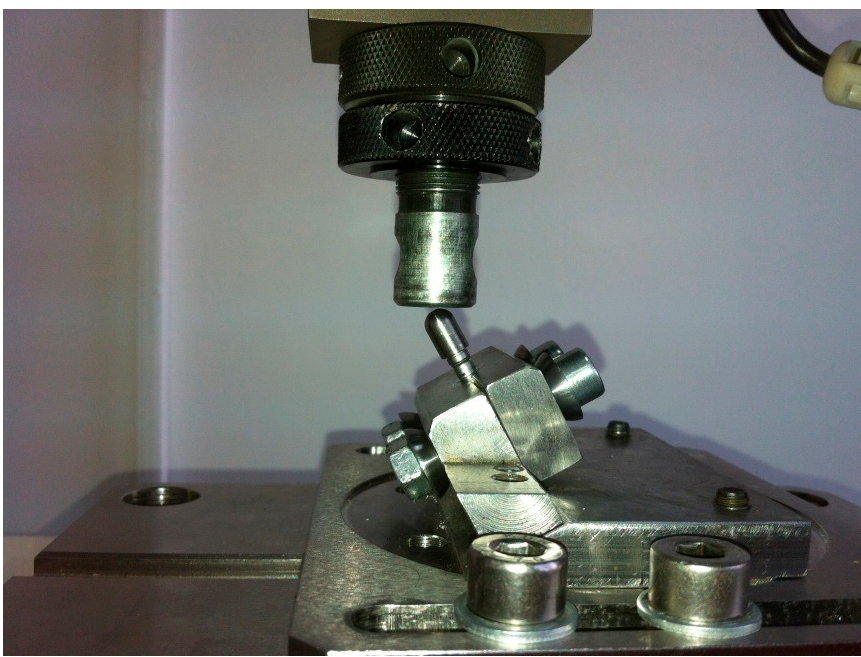
Figure 8. Commencement of the static test.